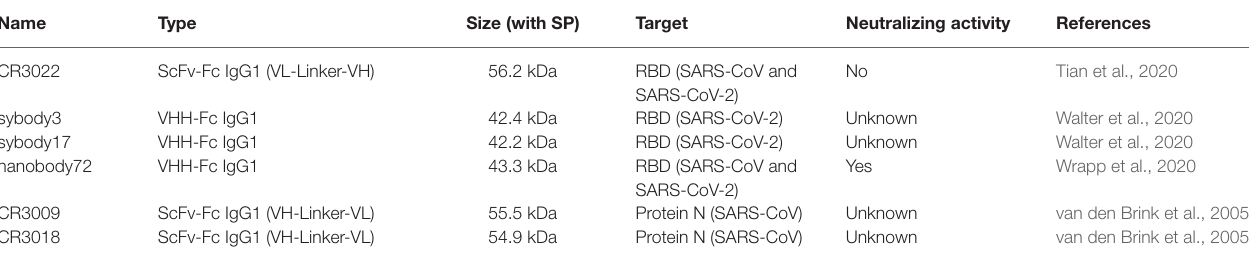
TABLE 1 | Detailed information of six different antibodies selected for recombinant expression in